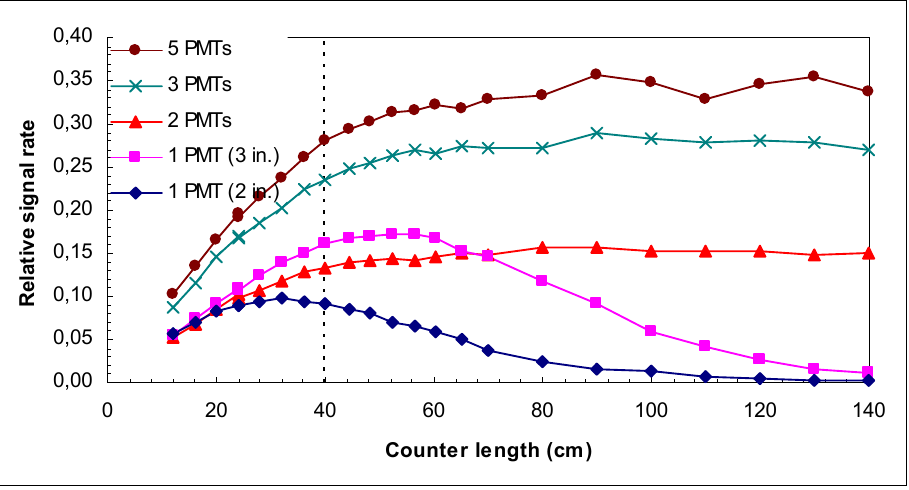
Figure 5. Graph of the relative event rate in the water cavity as a function of counter length and number of PMTs on each end. Configurations with more than one PMT per end have single-end coincidence requirements while those with only one PMT have a two-end